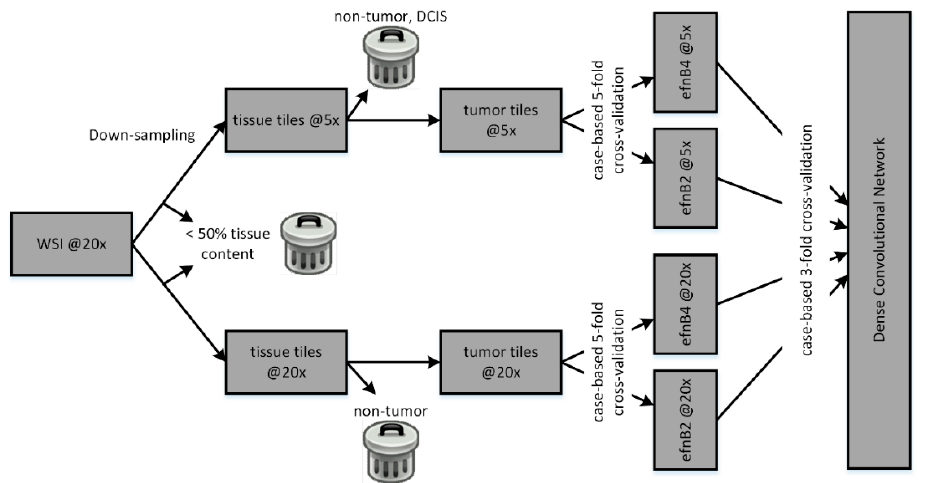
Figure 5. Overall architecture of the model developed by team